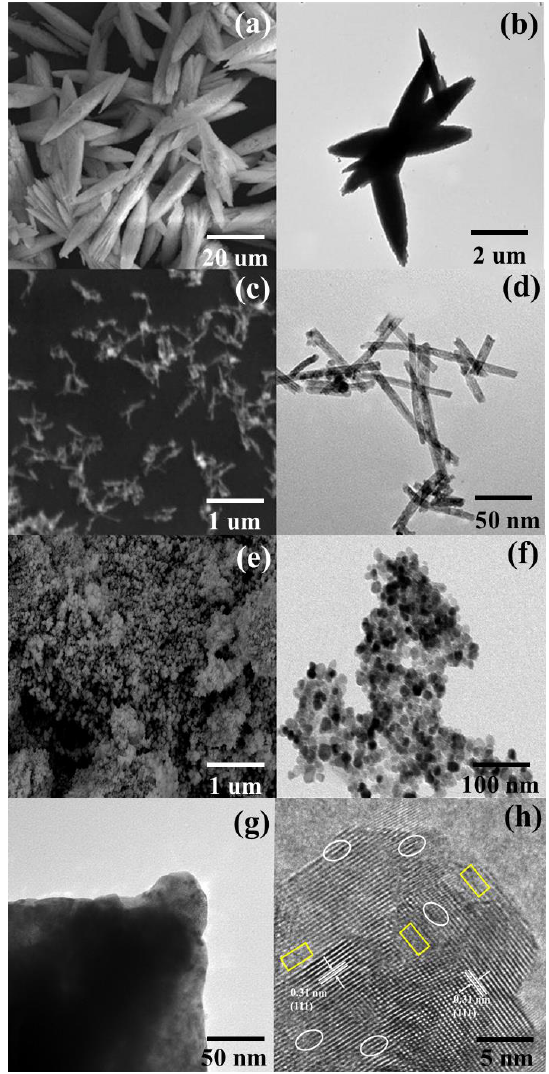
Figure 3. SEM and TEM images of CeO 2 (S) ( a , b ), CeO 2 (R) ( c , d ) CeO 2 (P) ( e , f ) and HRTEM image of CeO 2 (S) ( g , h